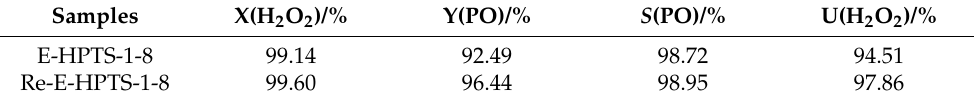
Table 4. Catalytic performance of fresh and regenerated E-HPTS-1-8 in batch reactor.